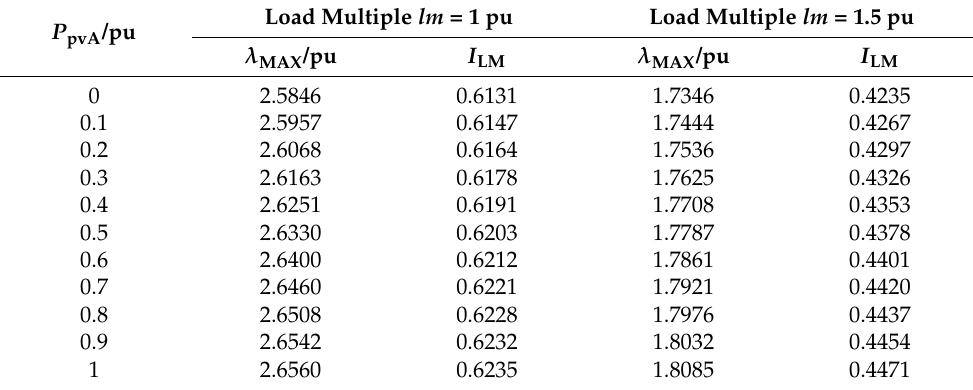
Table 4. Values of system load-margin index (Plan A, active output of Gen 2 P G2 = 0.4